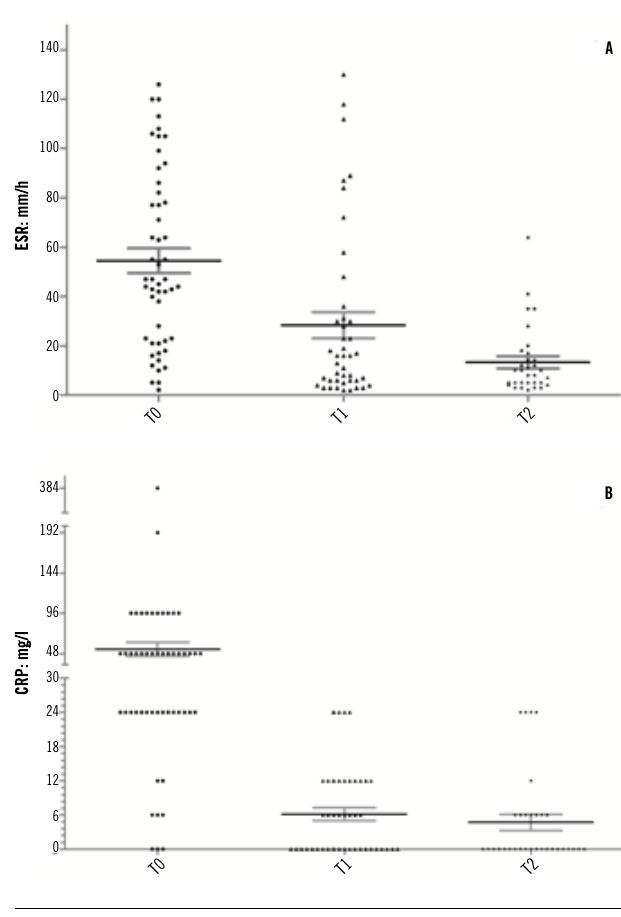
figurE 1 – Column graphs using ANOVA test, showing the relation between ESR and CRP at TO, T1, and T2 Test significance for * p < 0.05; ** p < 0.005; *** p < 0.0005. A) p < 0.0001***; B) p < 0.0001***. ANOVA: analysis of variance; ESR: erythrocyte sedimentation rate; CRP: C-reactive protein; T0: time of diagnosis, before starting treatment; T1: after three months of treatment; T2: at the end of